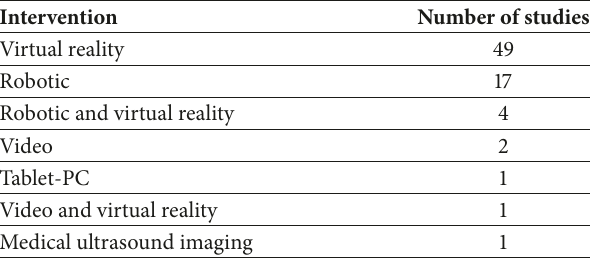
Table 8: Type of intervention of included studies.